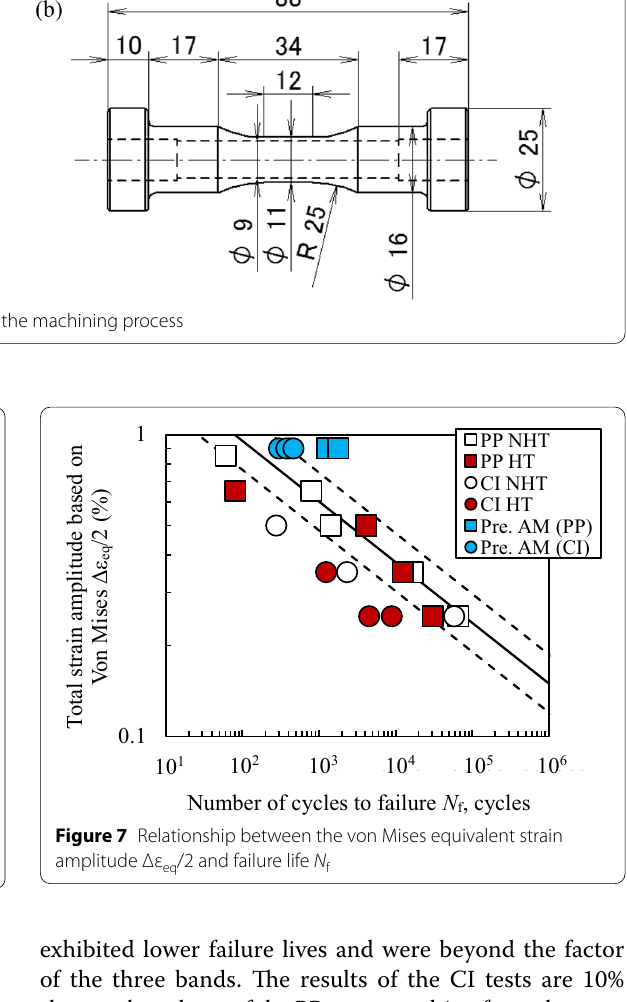
Figure 6 Representation of the PP and CI strain path used